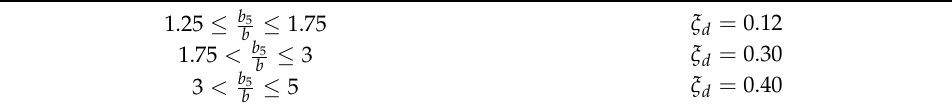
Table 5. Localized resistance coefficient as a function of the ratio b 5 / b